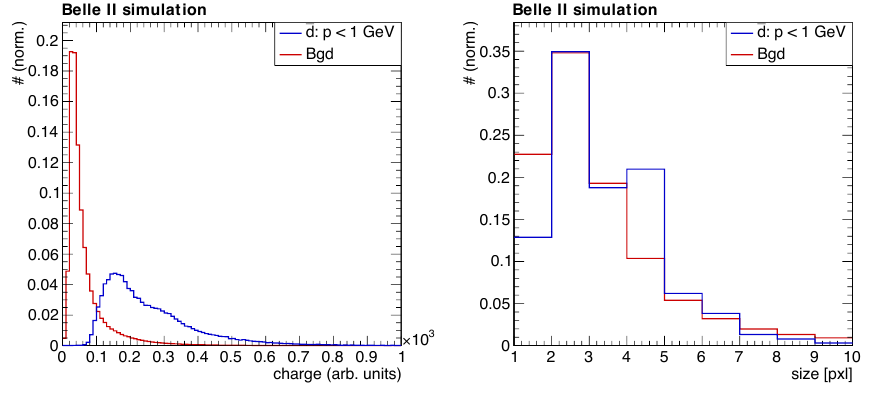
Figure 3: Cluster charge and cluster size for anti-deuterons and background. Background and anti-deuteron distributions are not separated as neatly as for magnetic